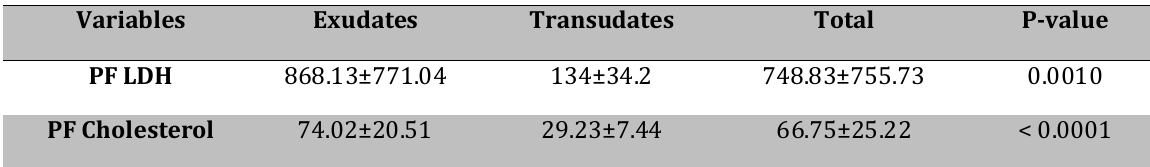
Table 2. Pleural fluid LDH and Pleural fluid cholesterol analysis in exudates and